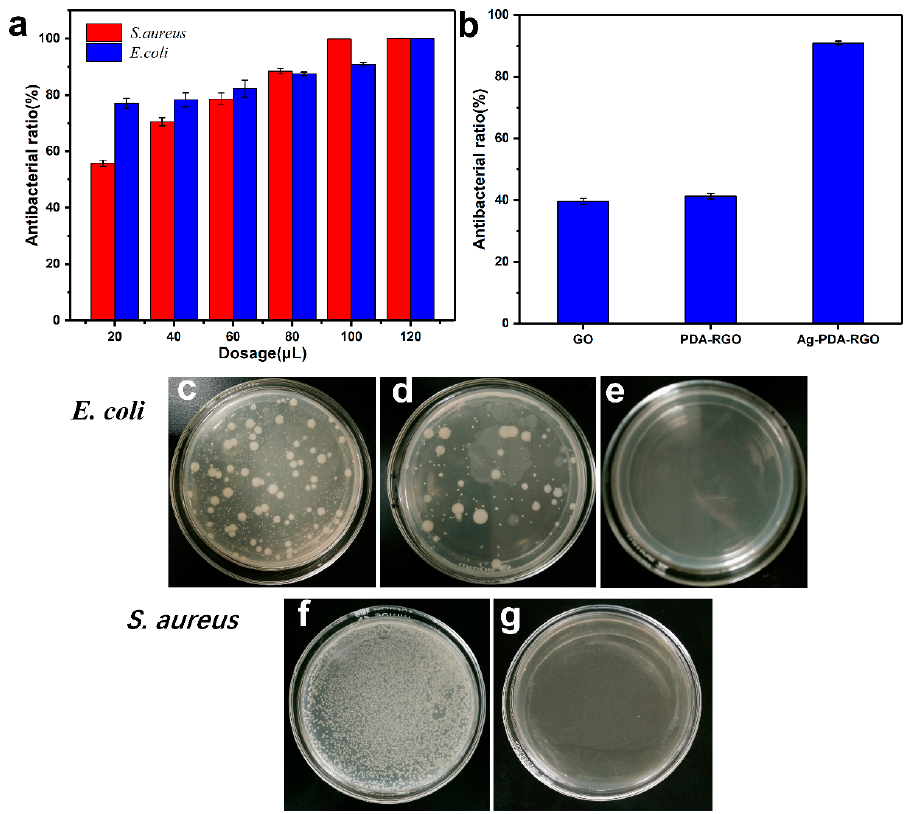
Figure 5. The antibacterial property against Staphylococcus aureus and Escherichia coli with a different dosage of Ag-PDA-RGO ( a ), antibacterial property comparison against E. coli with 100 μ L of 100 mg/L GO, PDA-RGO, and Ag-PDA-RGO ( b ), the photographs of initial bacterial colonies formed by S. aureus ( c ), E. coli ( f ), and the bacterial colonies images after adding 100 μ L ( d and g ) and 120 μ L ( e ) of 100 mg/L Ag-PDA-RGO nanocomposites.